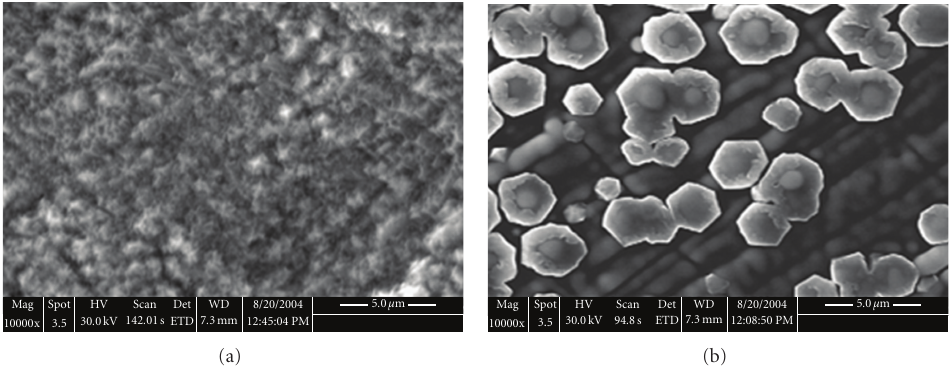
Figure 8: SEM photographs of electrodeposition of Zn-Ni on steel at 4mA/cm 2 . (a) | CdSO 4 | = 1.5g/L, (b) | CdSO 4 | = 2.5g/L.